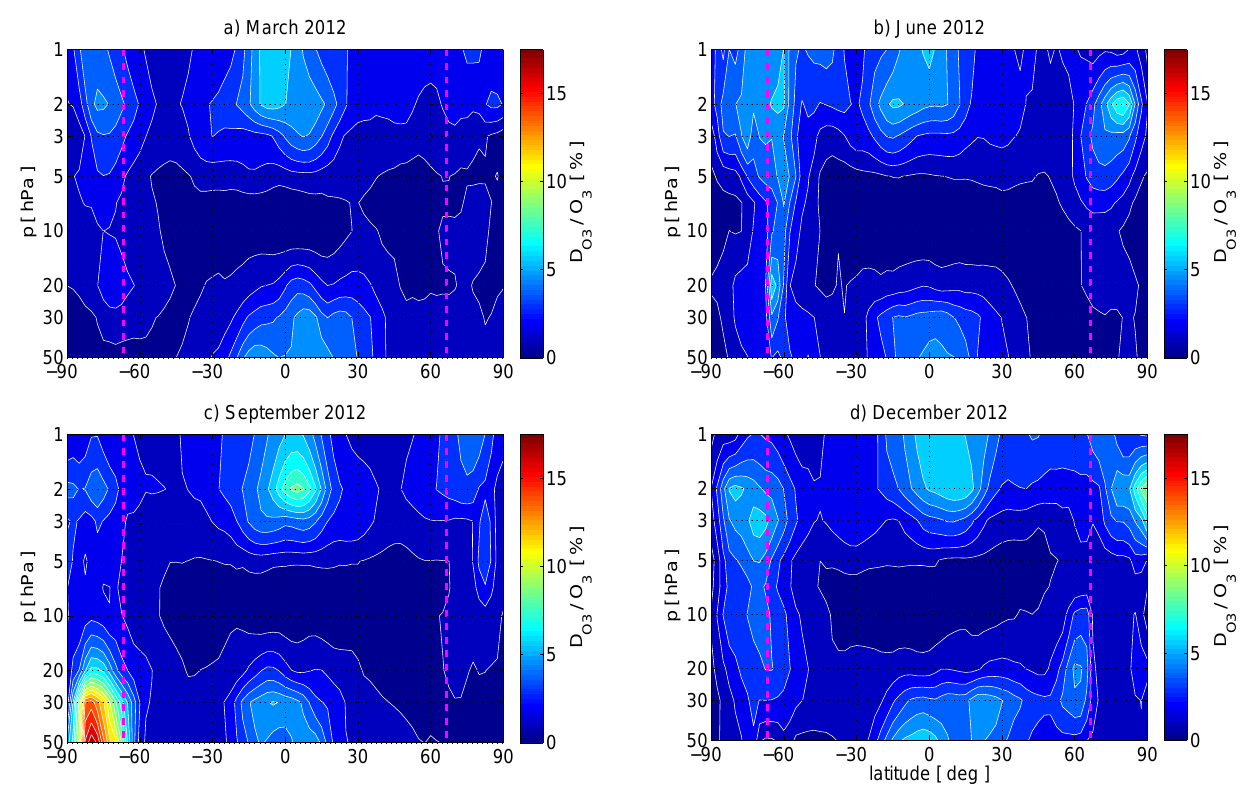
Figure 4. Same as Figure 2 but derived from